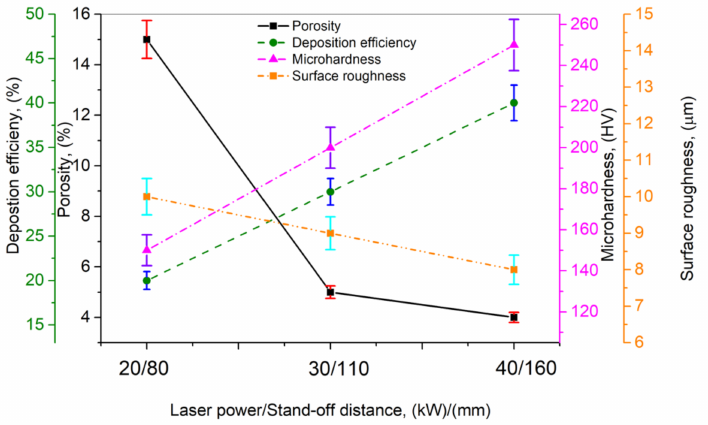
Figure 6. Effect of laser power/standoff distance on porosity, deposition efficiency, microhardness, and surface roughness; based on the data given in Reprinted from permission from [77]. Copyright year Copyright owner’s name [77].